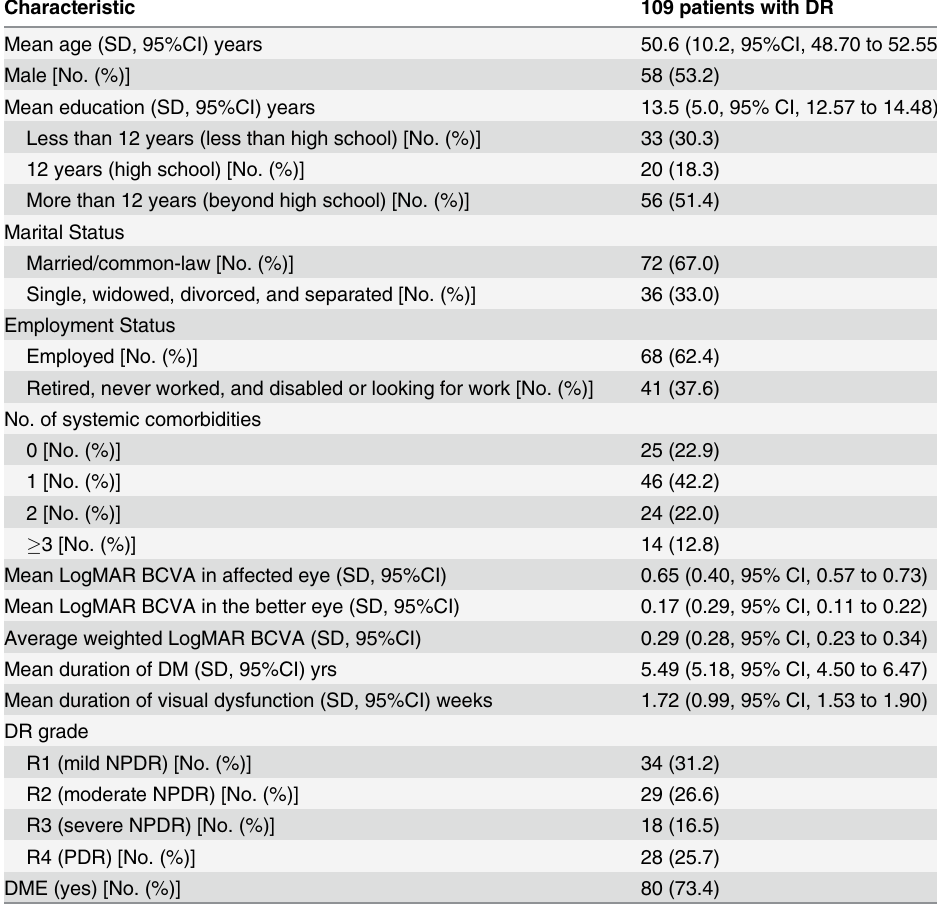
Table 1. Demographic and clinical characteristics of 109 patients with diabetic retinopathy.